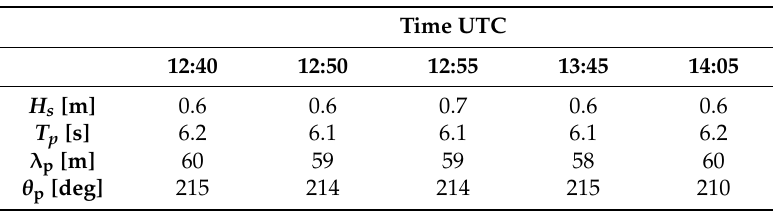
Table 4. Sea state parameters provided by the wave radar system during the measurement campaign on 15 May 2015.